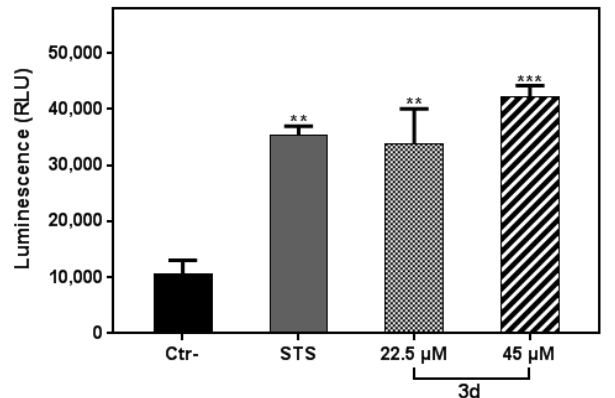
Figure 5. Apoptosis induction in K562 cells treated with 3d for 24 h in the presence of RealTime-GloTM Annexin V Apoptosis and Necrosis Assay reagent. RLU (left panels, PS: annexin V binding) was collected. Staurosporine (STS) was used as the positive control. Data represent the mean of 2 readings for each replicate ± SD. All data were statistically significant ( p < 0.05). **, and *** denote p < 0.01, and 0.001, respectively.